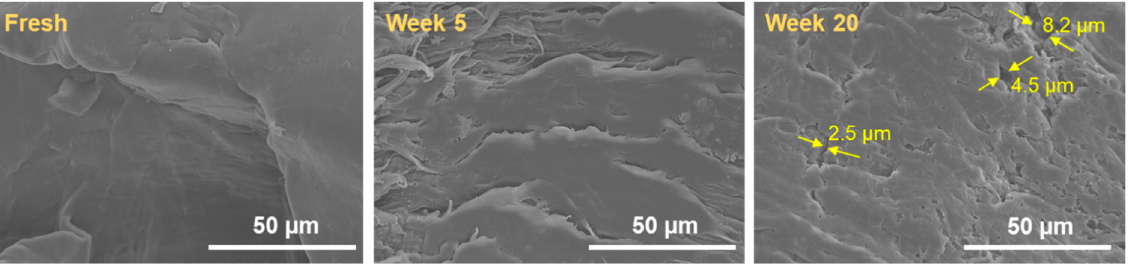
Figure 3. Fracture surface morphology of a neat HDPE sample before and after ageing in a QUV chamber. (Arrows point to the minimum cracks propagated into the polymer interior after 20 weeks of ageing).